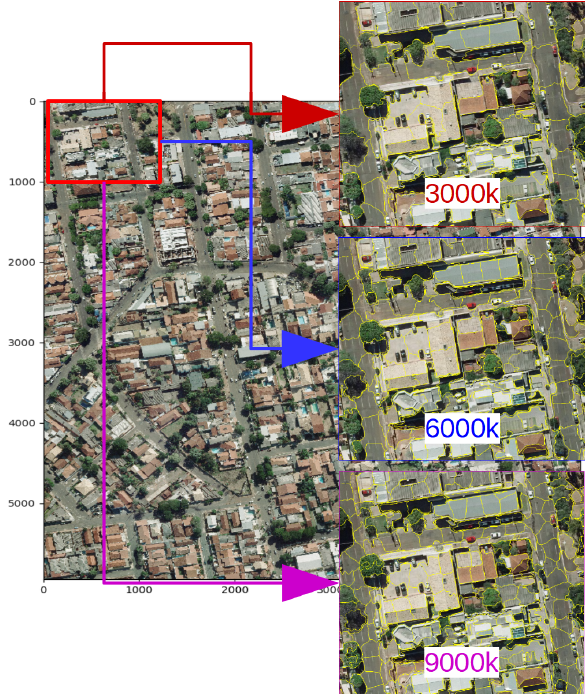
Figure 3. Original image with a detach for a particular region. The impact of different values for k can be verified in the amplified images.Superpixels are in yellow